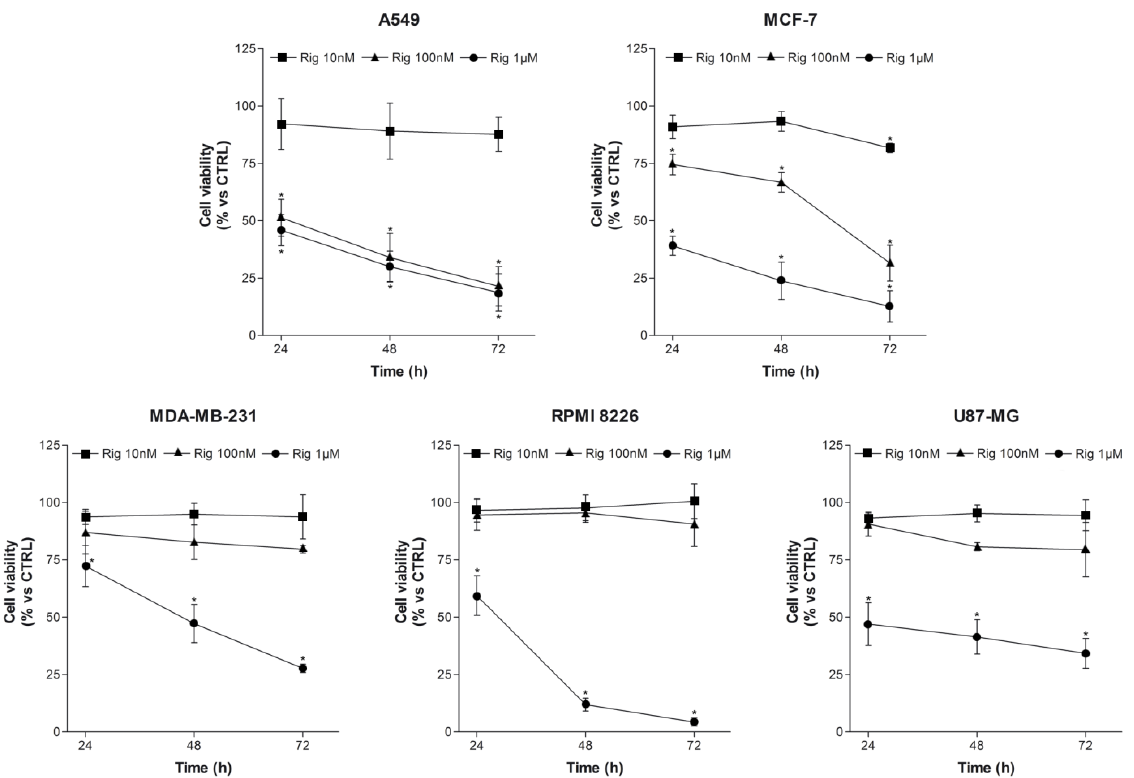
Figure 1. Evaluation of cancer cell viability and death after Rig treatment. Cell viability of A549, MCF-7, MDA-MB-231, RPMI 8226, and U87-MG cells was evaluated by MTT assay after 24, 48, and 72 h of treatment, with or without different concentrations of Rig (Rig 10 nM, 100 nM, 1 µM). * p < 0.05 vs. CTRL.